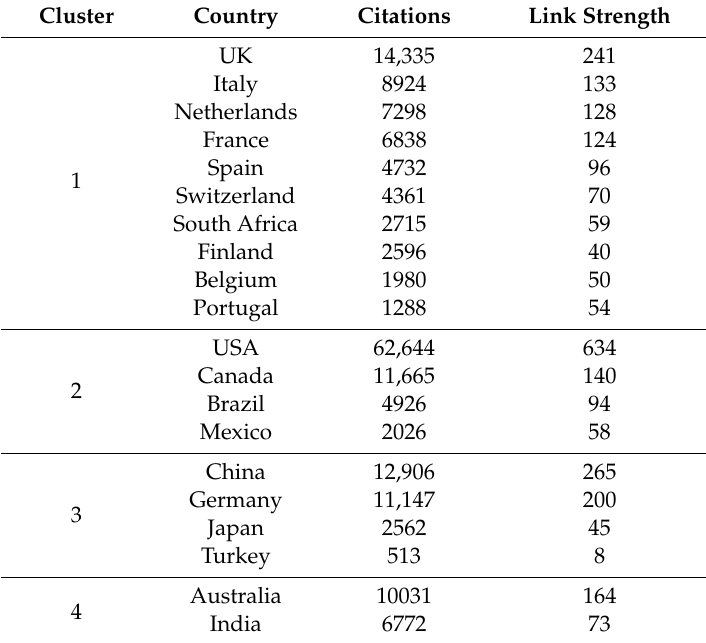
Table 2. 5 main clusters for country collaboration.